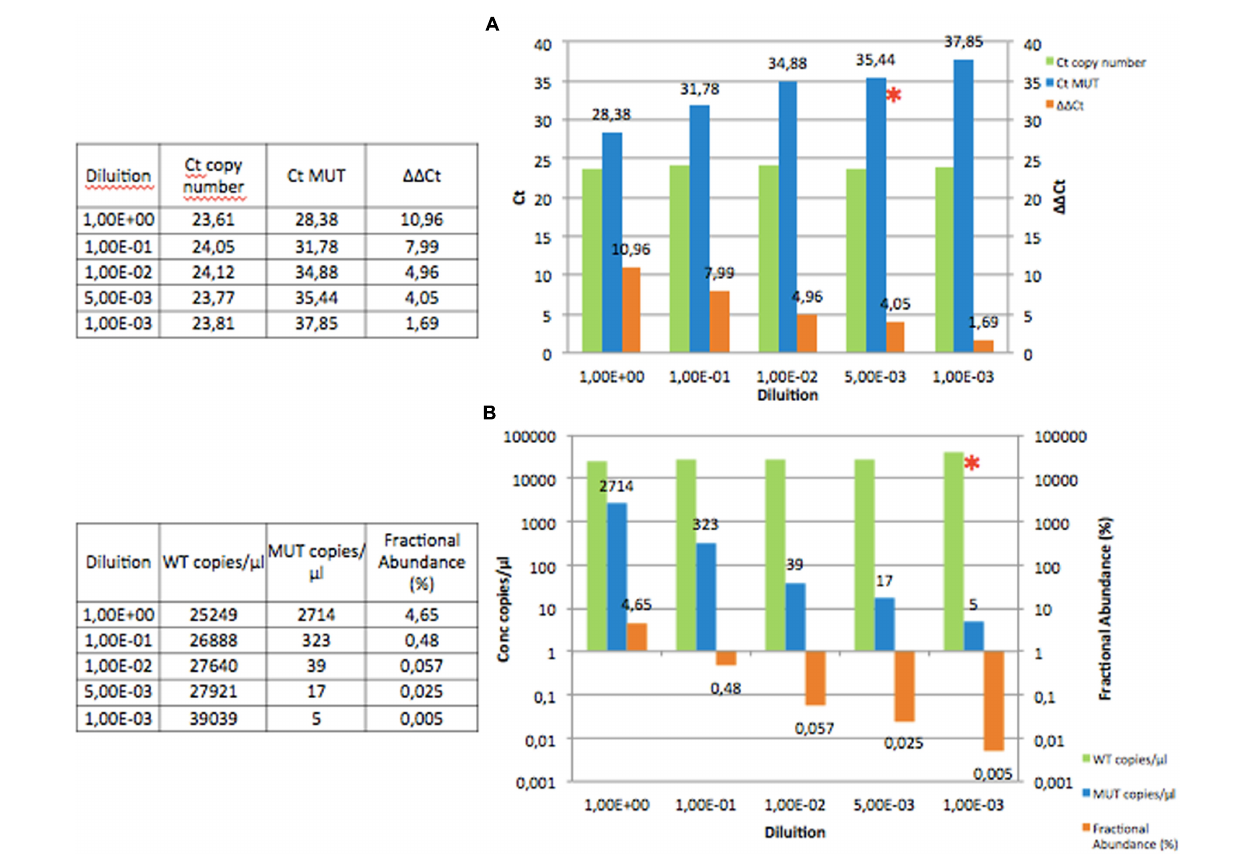
FIGURE 1 | Diluting a DNA from a HCL patient with 5% of B-RAF mutation in a pool of five wild-type DNAs in a half-logarithmic scale, from the 1 × 10 to the 1 × 10 − 4 dilution. (A) In the QT-PCR the copy number Ct remained constant (green), while the mutated Ct increased (blue). In orange the trend of the (cid:49)(cid:49) Ct which is reduced up to 1.69. The 1 × 10 − 3 dilution should be considered negative, because Ct was > 37 and (cid:49)(cid:49) Ct < 4.0. (See Materials and Methods) The ∗ indicates the last dilution point that can be accepted (1 × 10 − 3 ). (B) In the dd-PCR the copy number concentration remained constant (green), while the mutated concentration reduced (blue). In orange the trend of the fractional abundance (%) which reduced up to 0.005. The ∗ indicates the last dilution point that can be accepted (1 × 10 − 3 ). Ct. cycle threshold; MUT, mutated; WT,